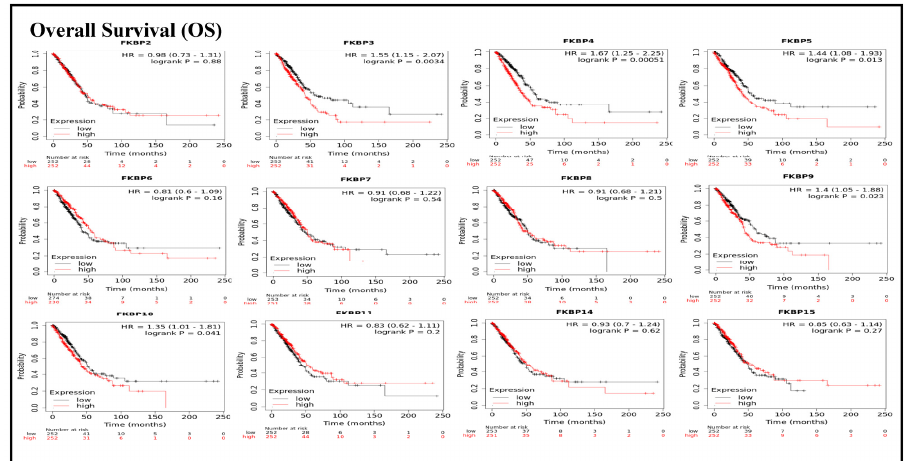
Figure 1. The mRNA expression levels of FKBP family members in various cancer types an ‐ alyzed using the Oncomine database. Transcriptional levels of FKBP2 , FKBP3 , FKBP4 , FKBP10 , FKBP11 , and FKBP14 were higher in lung cancer samples than in normal samples. Red and blue cells, respectively, represent statistically upregulated and downregulated mRNA expression levels of FKBP family members. The threshold was set to a fold change of p <0.05; fold change >1.5 p=0.05; gene rank top 10%.